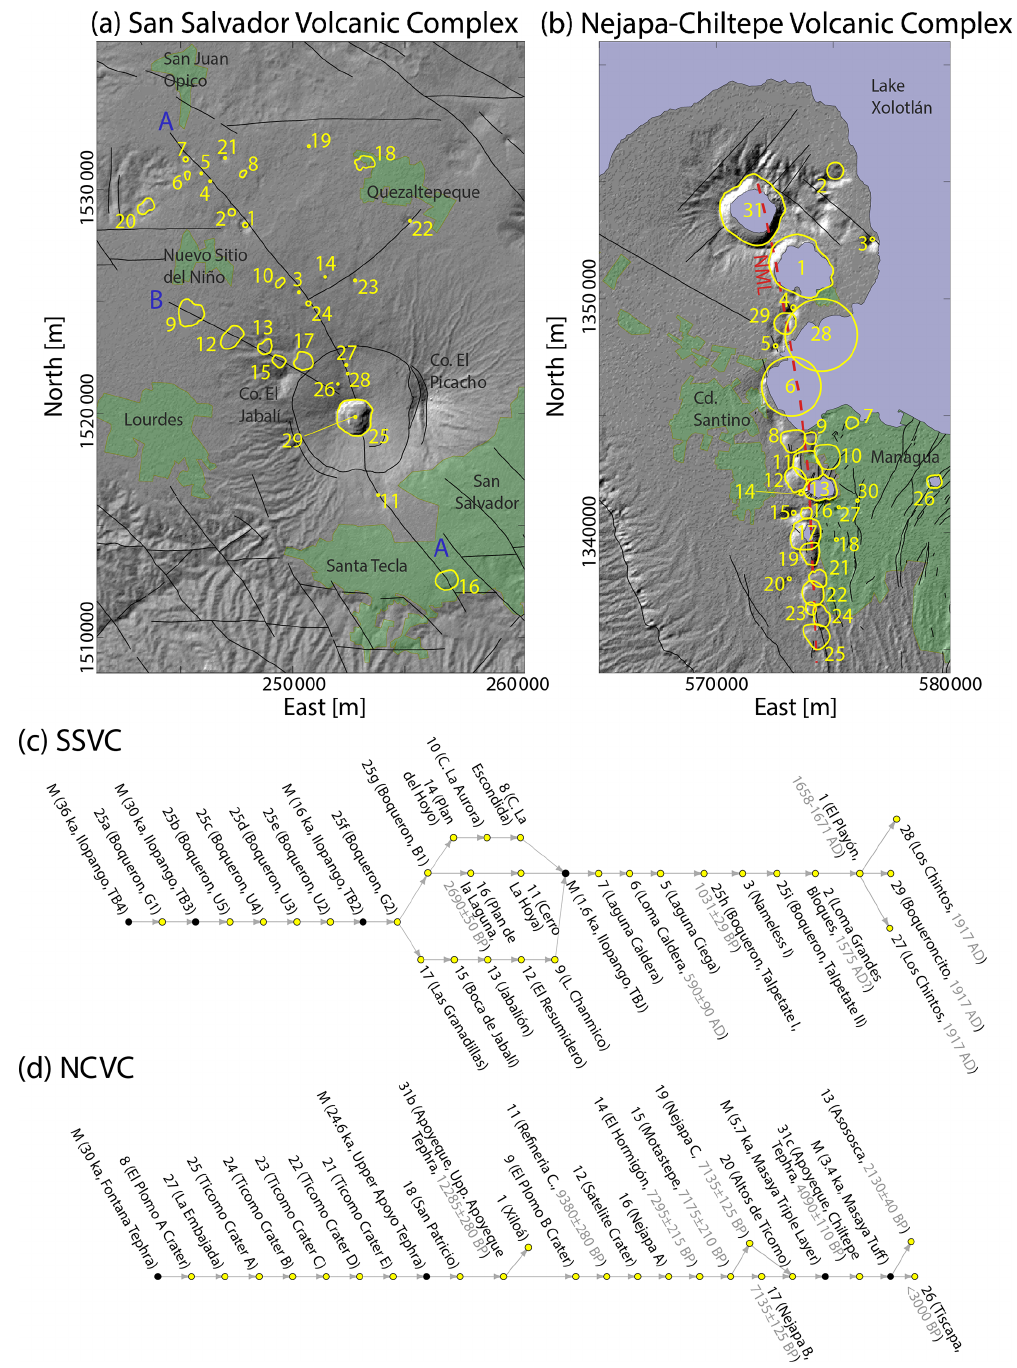
Figure 1. (a, b) Topographic maps of the San Salvador volcanic complex (a) , mainly based on Ferrés et al. (2011), and the Nejapa-Chiltepe volcanic complex (b) , mainly based on Avellán et al. (2012). Data associated with the vents of past eruptions and major structures are also presented, which were employed for the construction of thematic vent opening probability maps. In panel (a) , the letter A refers to a N40W- trending fault and the letter B refers to a N65W-trending fault. Eruptions 25a ( ∼ 36kaBP) and 25g ( ∼ 3kaBP) mark the limits between the three evolution stages defined for the SSVC. In panel (b) , NML refers to the Nejapa-Miraflores lineament. The green zones present indicative limits of the urbanized areas. (c, d) Schemes of the eruptive sequences associated with the San Salvador volcanic complex (c) and Nejapa-Chiltepe volcanic complex (d) . Yellow symbols represent their eruptions (see Tables 1 and 2) and black symbols represent regional stratigraphic markers. Eruption numbers refer to the vents (see panels a and b ) and letters are used to identify different eruptions from a single vent. Bifurcations are used to separate sets of eruptions whose chronostratigraphic relationship is not